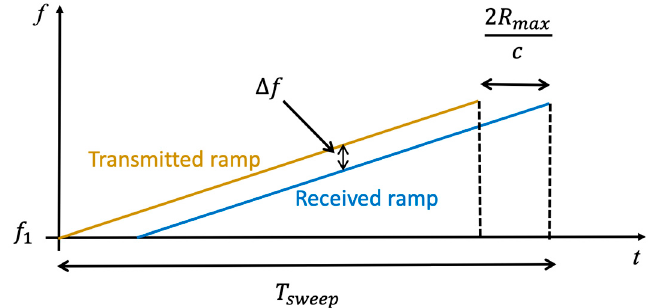
Figure 13. FM modulation.